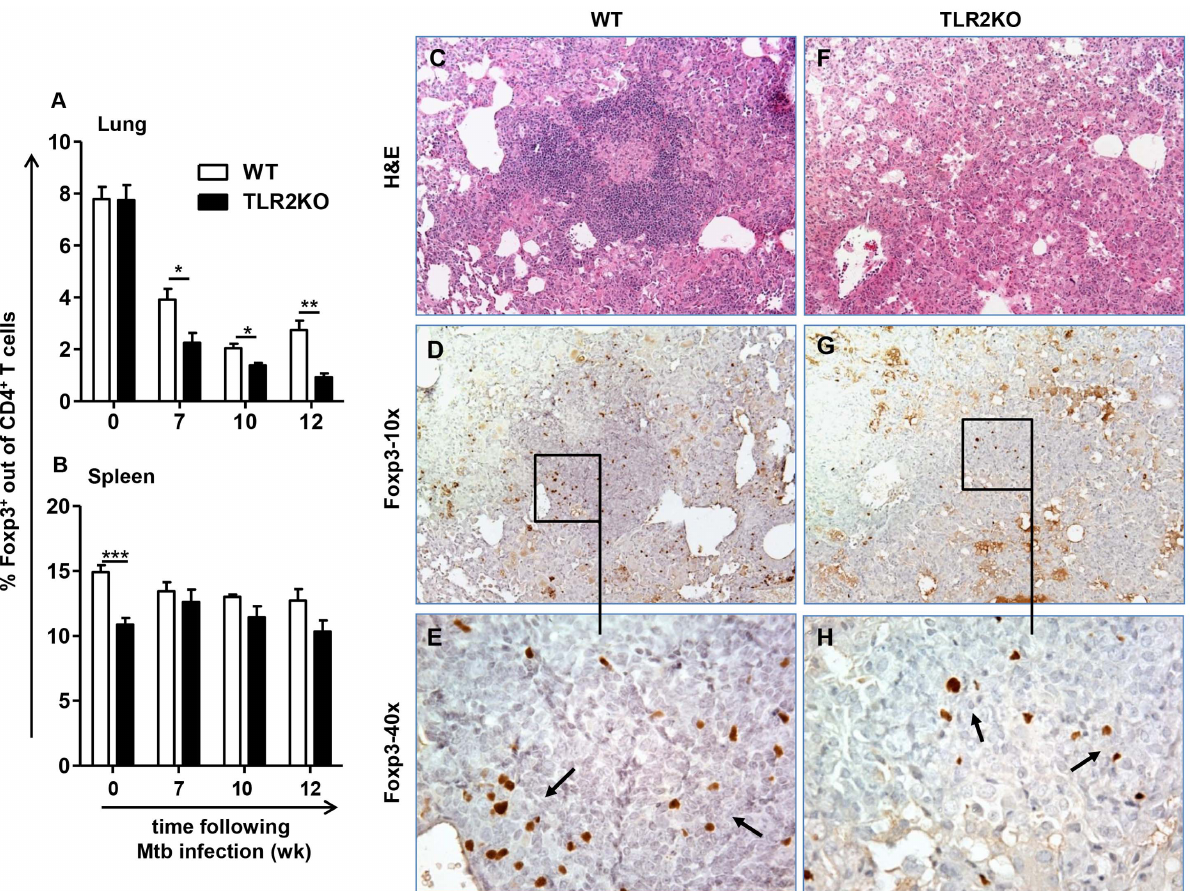
Figure 2. Decreased natTregs observed in the lungs in the absence of TLR2. Lungs and spleens were harvested from WT and TLR2KO mice, and single cell suspensions were prepared at the indicated time points after Mtb challenge. Cells were stained with antibodies against CD4, followed by intracellular staining for Foxp3. Expression of Foxp3 is presented as percentage of the CD4 + cell population in lung (A) and spleen (B). 11 mice per group were included for uninfected (week 0=uninfected). Each time point post-infection (weeks 7, 10, and 12) represents 5 mice per group. Post- infection Treg analysis shown is representative of 5 independent experiments. Data are presented as mean 6 SEM. *=p , 0.05, **=p , 0.01, ***=p , 0.001. Formalin-fixed, paraffin-embedded lung tissue was obtained at 12 weeks following infection. Serial sections showing areas of granulomatous inflammation in WT (C–E) and TLR2KO (F–H) mice are shown. Sections were stained with H&E (C and F) or with anti-Foxp3 (D, E, G and H). In sections stained with anti-Foxp3, areas within inflammatory lesions (D and G) are shown at higher magnification (E and H). Brown pinpoint staining indicative of Foxp3 + staining was not observed in serial sections stained with isotype control (not shown). Photomicrographs were taken at 10 6 (C, D, F, and G) and at 40 6 (E and H) original magnification. Sections are representative of 5 mice per